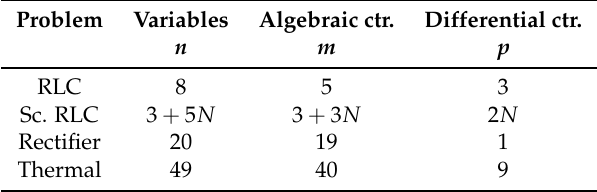
Table 3. Number of variables and constraints of proposed benchmark